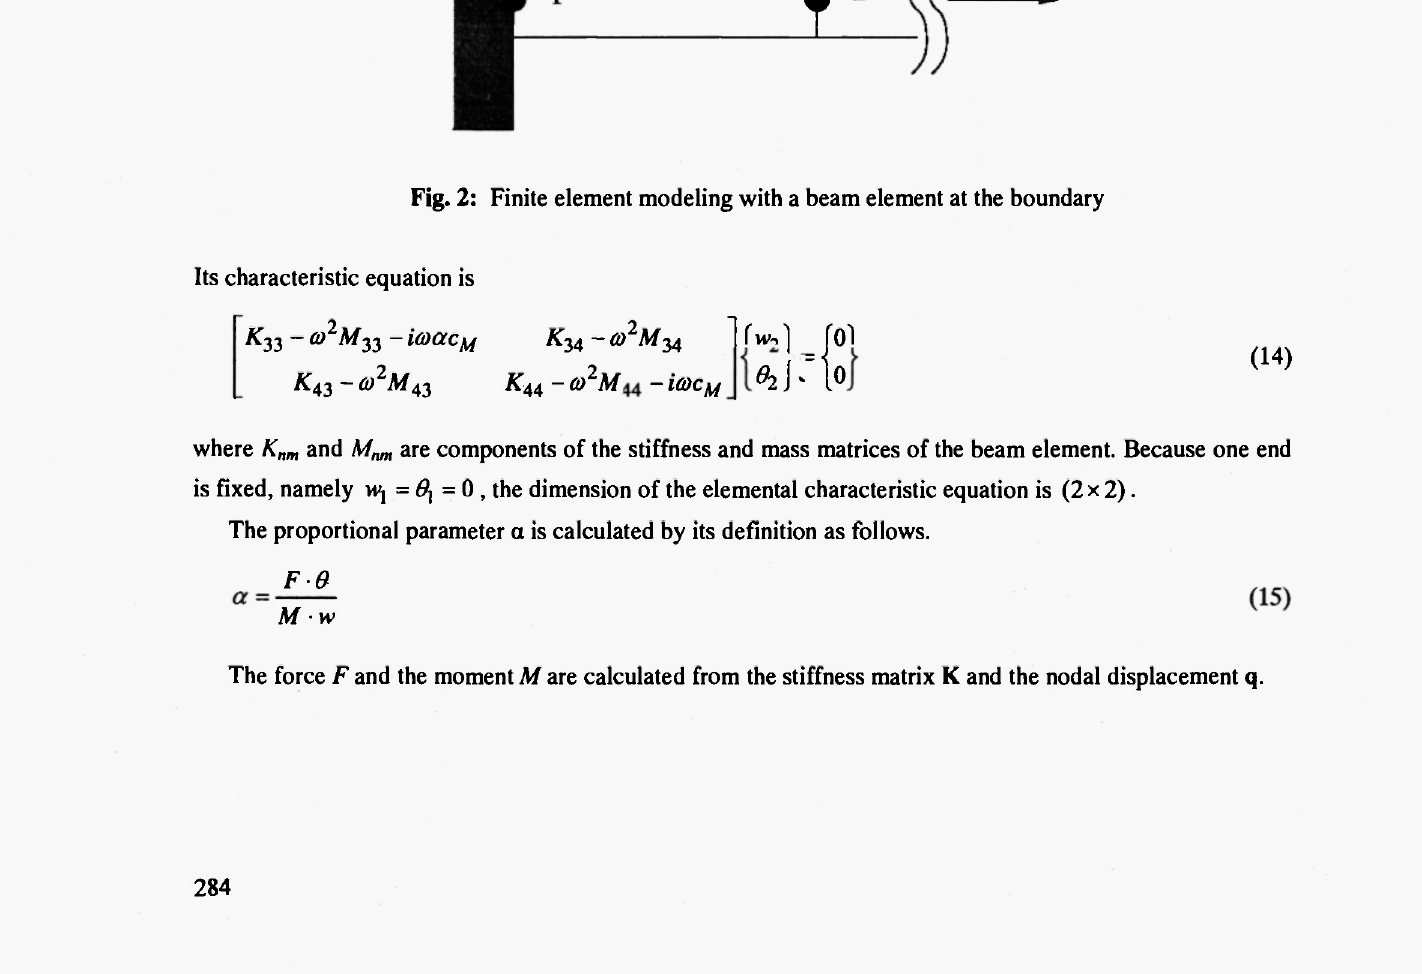
Fig. 2: Finite element modeling with a beam element at the